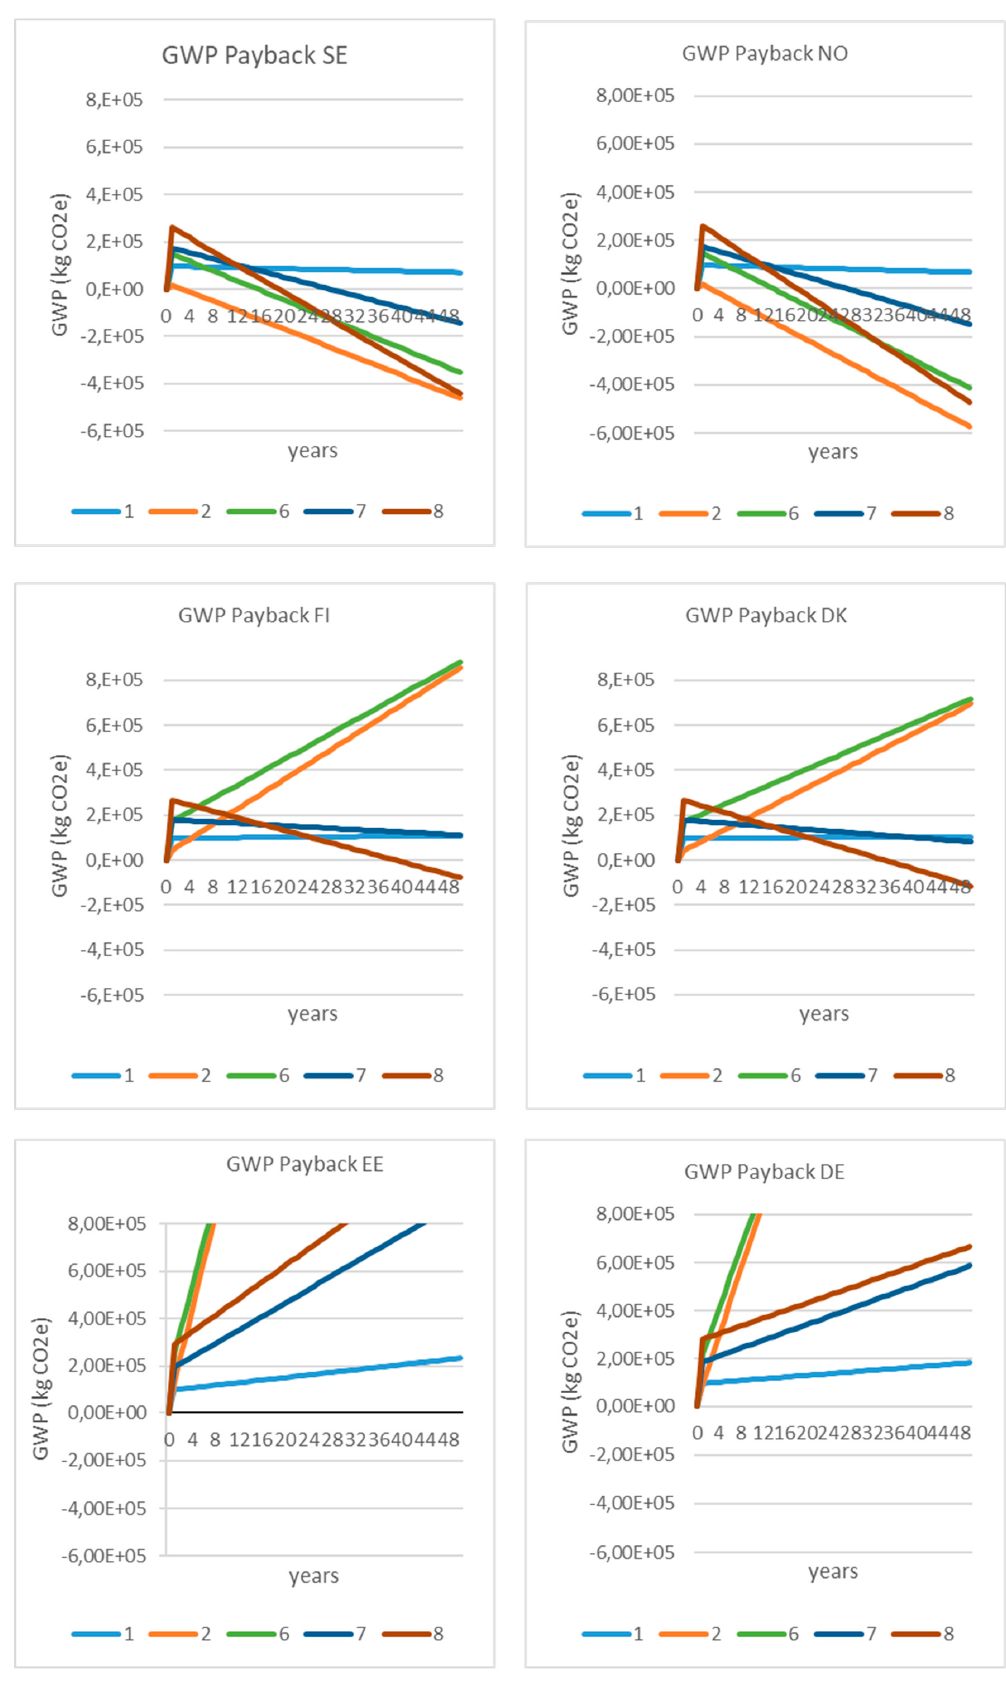
Figure 3. GWP Payback of the renovation scenarios based on di ff erent electricity